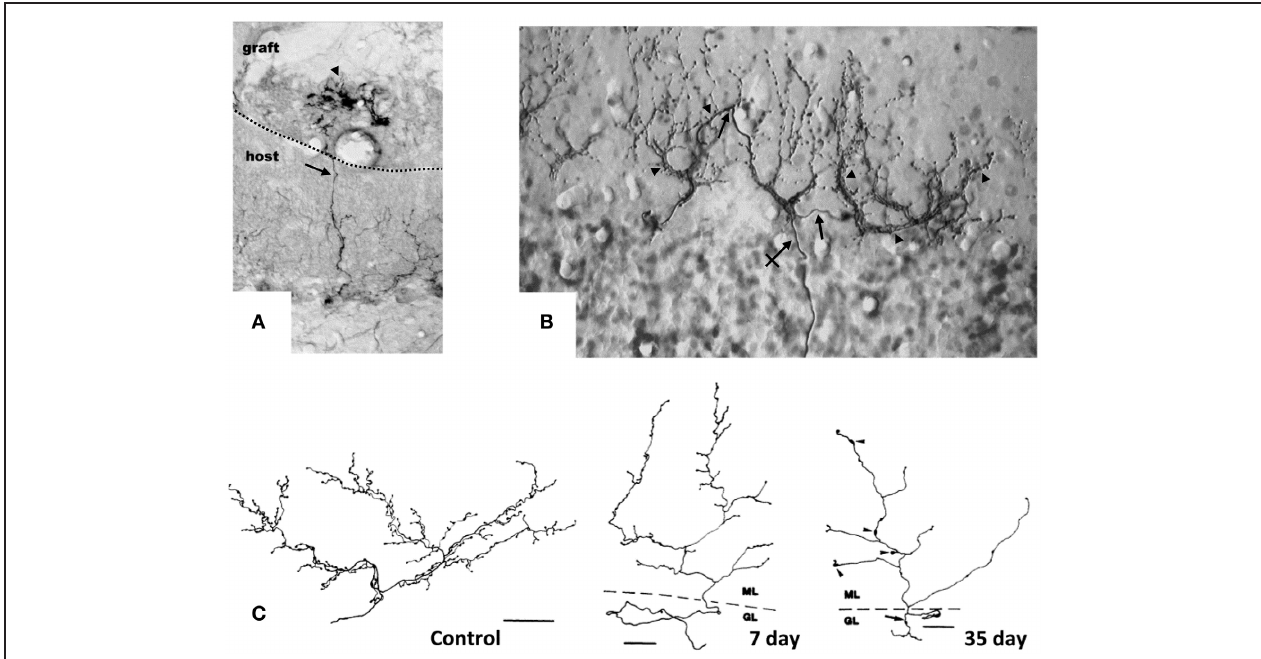
FIGURE 1 | Target-dependent structural plasticity of CFs. (A) Sprouting of adult CFs 7 days following transplantation of embryonic cerebellum on to the surface of the adult cerebellar cortex. The sprouts (arrows) innervate PCs in the graft (arrowheads). Dotted line: host-graft border (Rossi et al., 1994, unpublished). (B) CF sprouting and innervation of adjacent PCs previously denervated by a partial lesion of the IO, shown 1 year after the lesion on a sagittal plane. From 1 olivo-cerebellar axon (crossed arrow), a CFs is formed